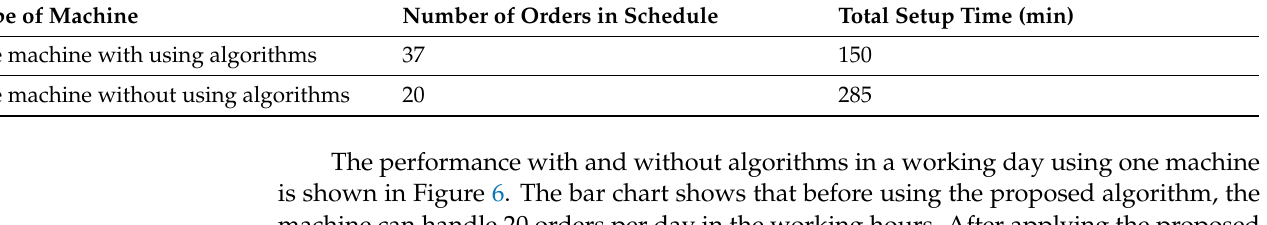
Table 4. The overall performance of the total number of orders and total setup time used in the schedule. Type of Machine Number of Orders in Schedule Total Setup Time